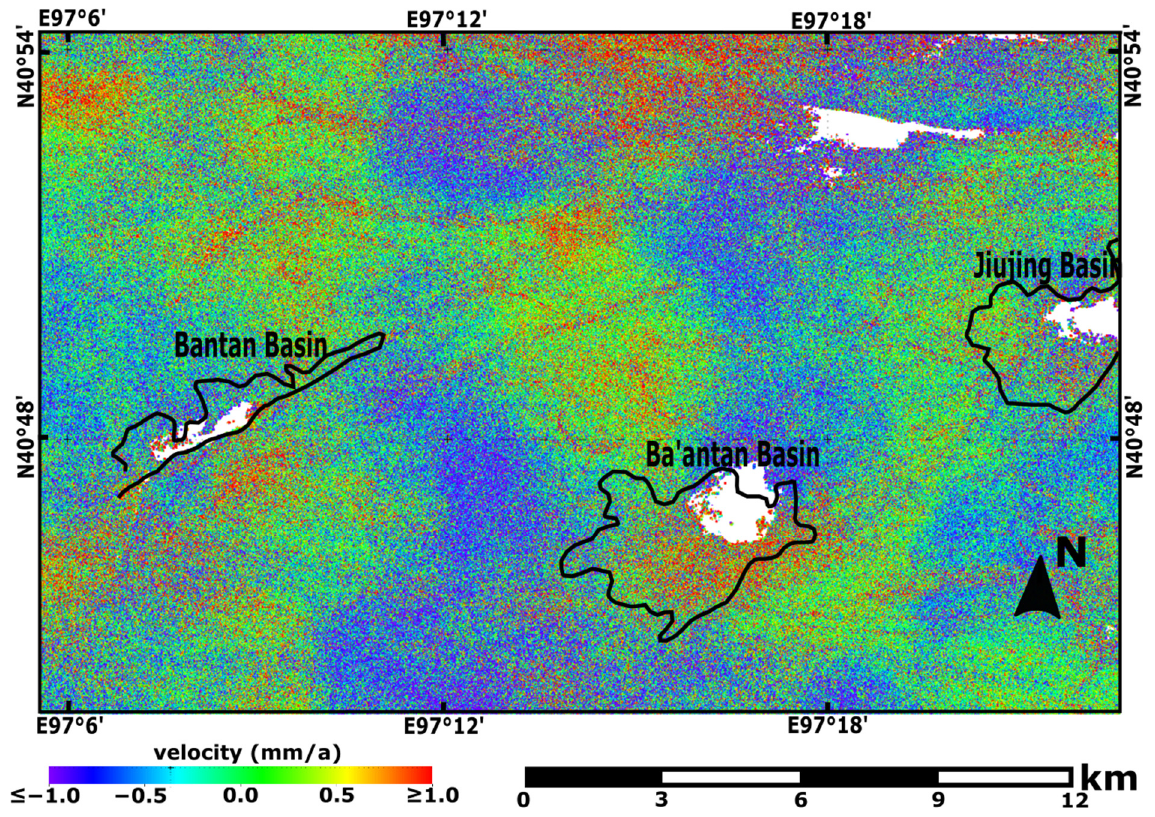
Figure 16. The locations of Bantan Basin, Ba’antan Basin, and Jiujing Basin within horizontal defor- mation (D E ) patterns (black outlines indicate Quaternary sediments).